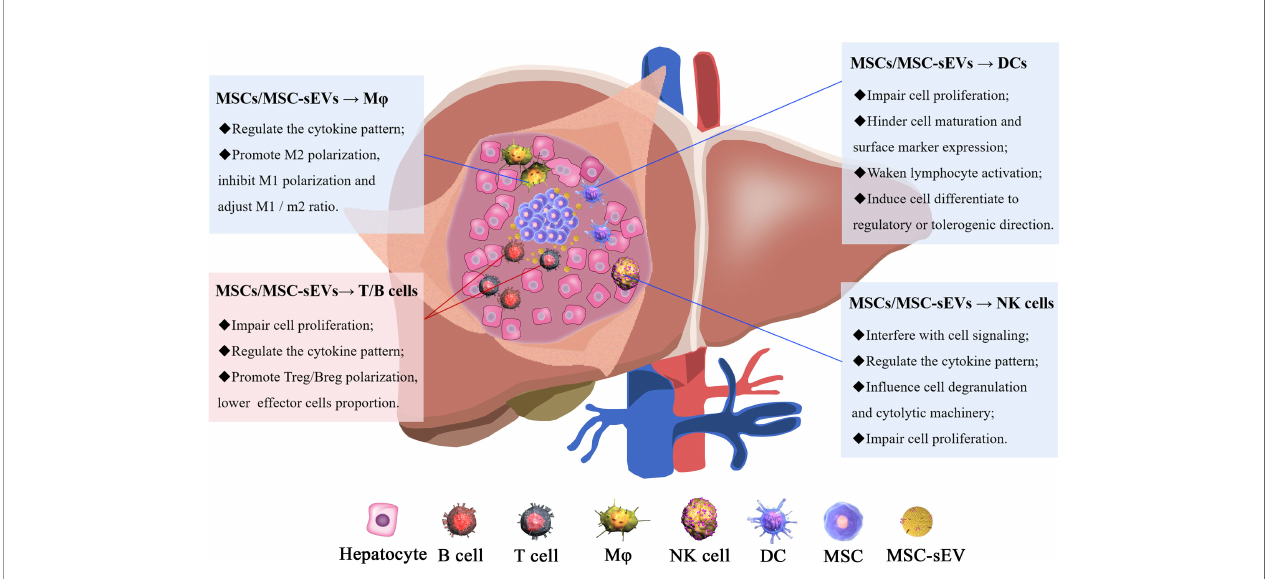
FIGURE 2 | The mechanisms of MSC/MSC-sEV modulation of immune cells. The immunomodulatory effect of MSCs/MSC-sEVs is re fl ected in their ability to inhibit immune cell proliferation and function and induce anti-in fl ammatory cell